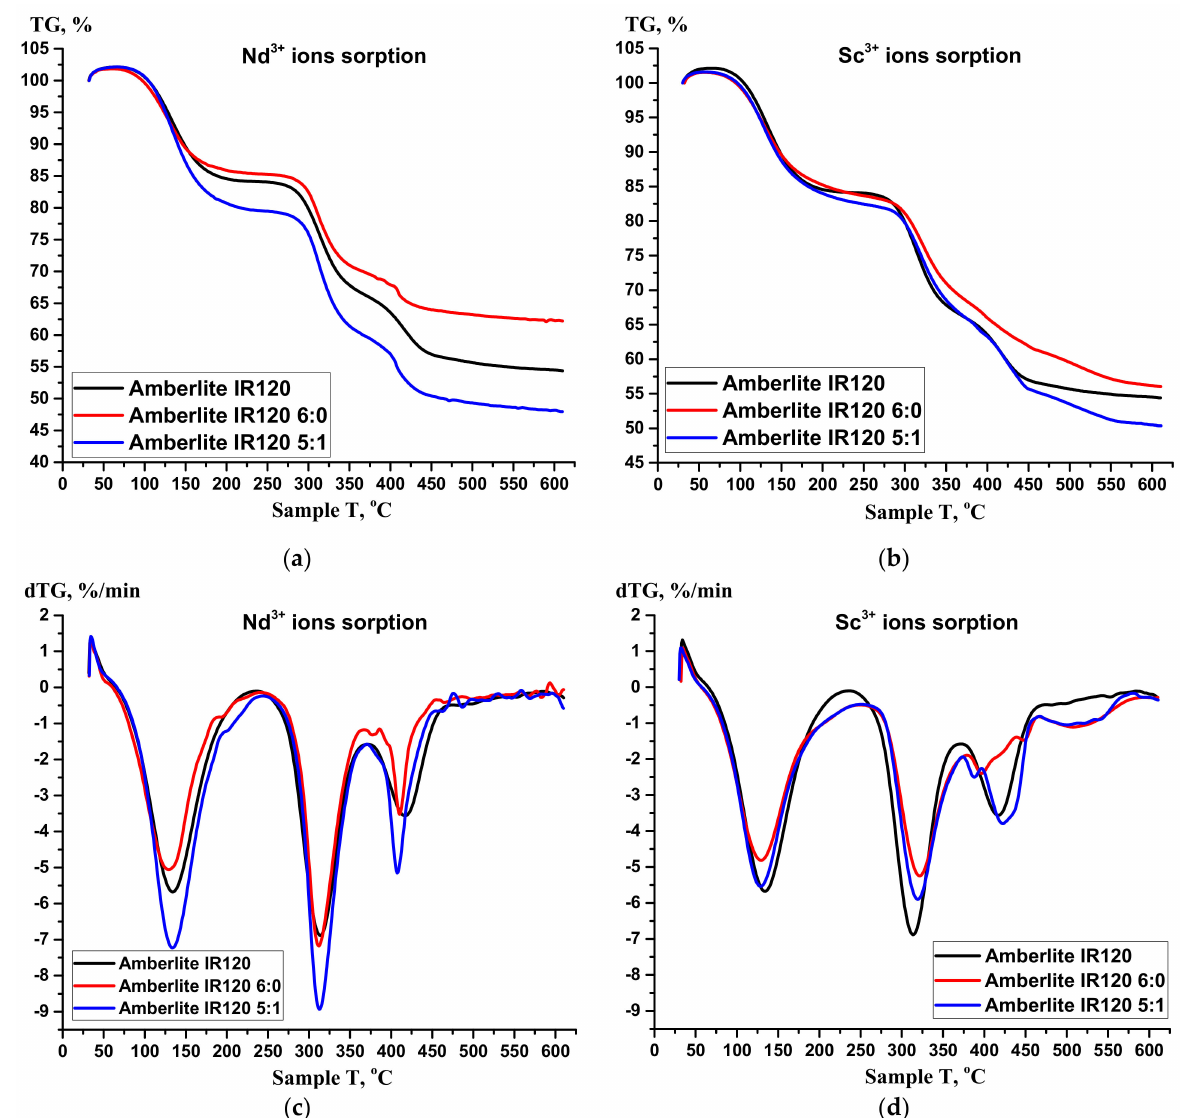
Figure 12. TGA curves of ( a , b ) mass loss and ( c , d ) rate of mass loss of Amberlite IR120. Figure 13 represents a comparison of the thermal destruction curves (mass loss (a) and rate of mass loss (c)) of individual AB-17-8, AB-17-8 from ratio 6:0 (with Nd 3+ ions) and AB- 17-8 from ratio 5:1 (with Nd 3+ ions) from time of interaction 0.5 h. A difference in mass loss of the three chosen samples of AB-17-8 is observed from 210 ◦ C; before this, temperature it occurs almost simultaneously. Further thermal decomposition is accompanied with strong mass loss from 380 ◦ C to 450 ◦ C, where the appearance of differences in the values of the mass loss is due to neodymium ions sorption. Further decomposition (in temperature interval from 450 ◦ C to 625 ◦ C) is accompanied by slight decrease of the mass loss due to stabilization of thermal destruction process. The figure represents comparison of thermal destruction curves (mass loss (b) and rate of mass loss (d)) of individual AB-17-8, AB-17-8 from ratio 6:0 (with Sc 3+ ions) and AB-17-8 from ratio 5:1 (with Sc 3+ ions) from time of interaction 15 h. Thermal destruction process occurs almost the same for the three chosen samples of AB-17-8 up to 225 ◦ C. Further destruction (from 225 ◦ C to 450 ◦ C) is accompanied with differences in the values of the mass loss is due to scandium ions sorption. After 450 ◦ C, a slight decrease of mass indicates a stabilization of the process of thermal